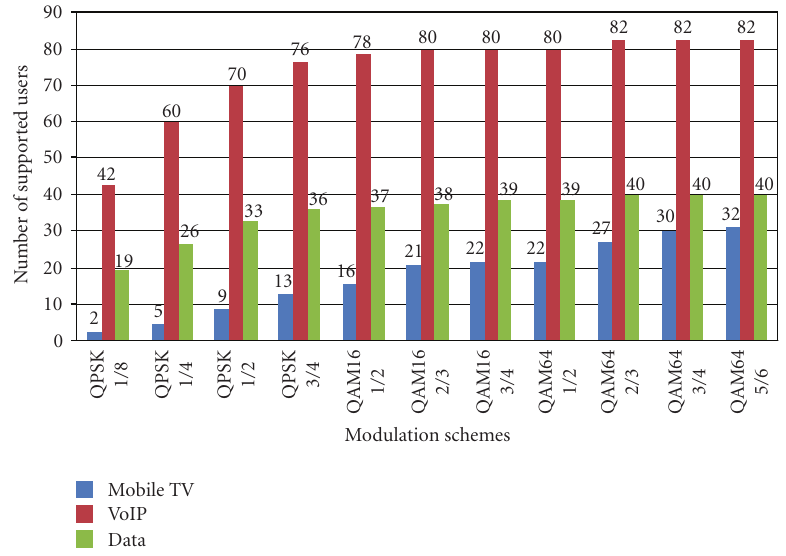
Figure 5: Number of users supported in a lossless channel (Simple scheduler).